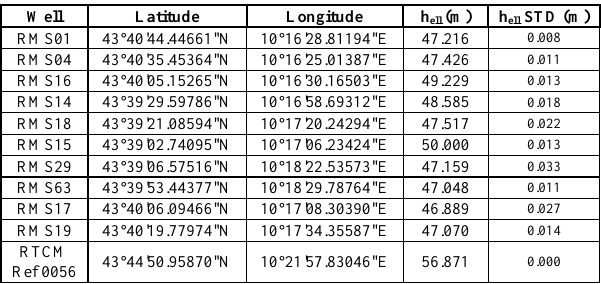
Table 1. Coordinates of wells by